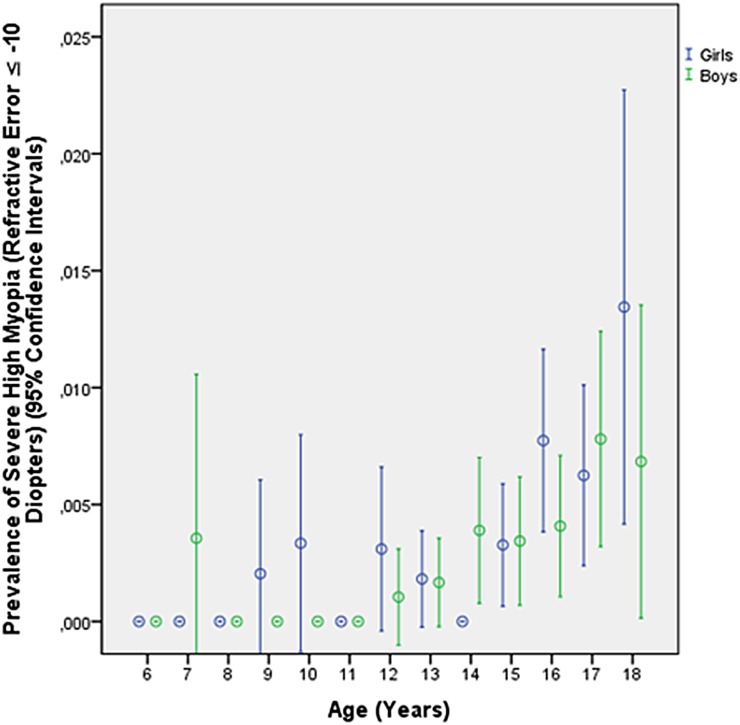
Diagram showing the prevalence of severe high myopia (myopic refractive error ≥-10.00 diopters) in the Greater Beijing School Children Myopia Study 2016.